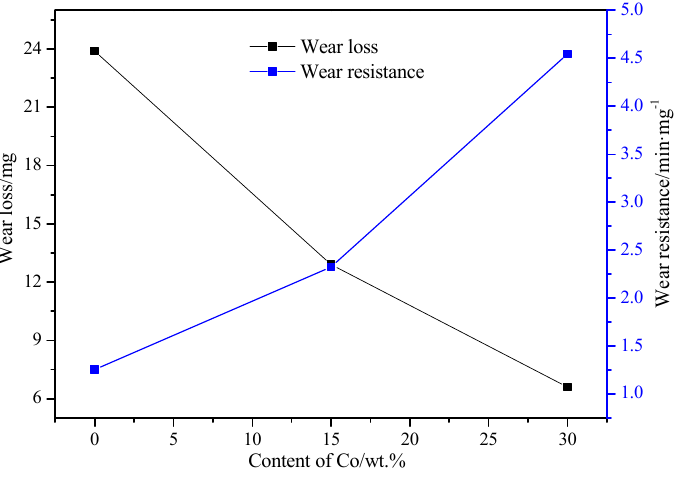
Figure 6. Weight loss and wear resistance of the cladding layers.